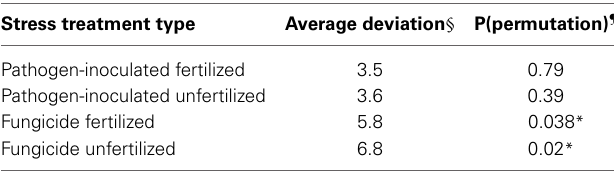
Table 2 | Microbial beta diversity within treatment blocks.